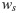
Wisdom of those resisting social influence for the question ‘What is the length of the Swiss/Italian border?’(A) Joint probability density of social weights ws and estimations y = log(x
1) and computed by Gaussian smoothing, Eq 7, of data (one black dot per individual). Smoothing from lowest resolution in the direction of the social weight ws (γwS = 6) to highest resolution (γwS = 2). (B) Geometric mean of estimations for groups containing individuals with social weight |ws|≤ω. At low ω the groups are formed by individuals resisting social influence. Blue dots: Groups with prediction not significantly different to wisdom of the crowd (WOC). Green dots: groups significantly different from WOC at p<0.05. Red dots: p<0.01. Value labelled ‘resist 1’ computed from individuals with low social weights and contributing more the values of ω with higher significance (Eq 8). Value labelled ‘resist 2’ computed as ‘resist 1’ but not weighting the different ω differently depending on significance levels. Line labelled ‘resist 3’ corresponds to the value of ω with highest significance. (C) Two clusters in the space of estimations and social weights obtained using Gaussian mixtures [26]. White ellipses delimit the area that contains 95% of the probability density for each of the bivariate Gaussians [27]. (D) Visual summary of the relative errors made by WOC, the three variants of the method in (B) and the center of the clusters obtained at low social weight at four levels of resolution in (C). Data taken from Lorenz et al. [9].